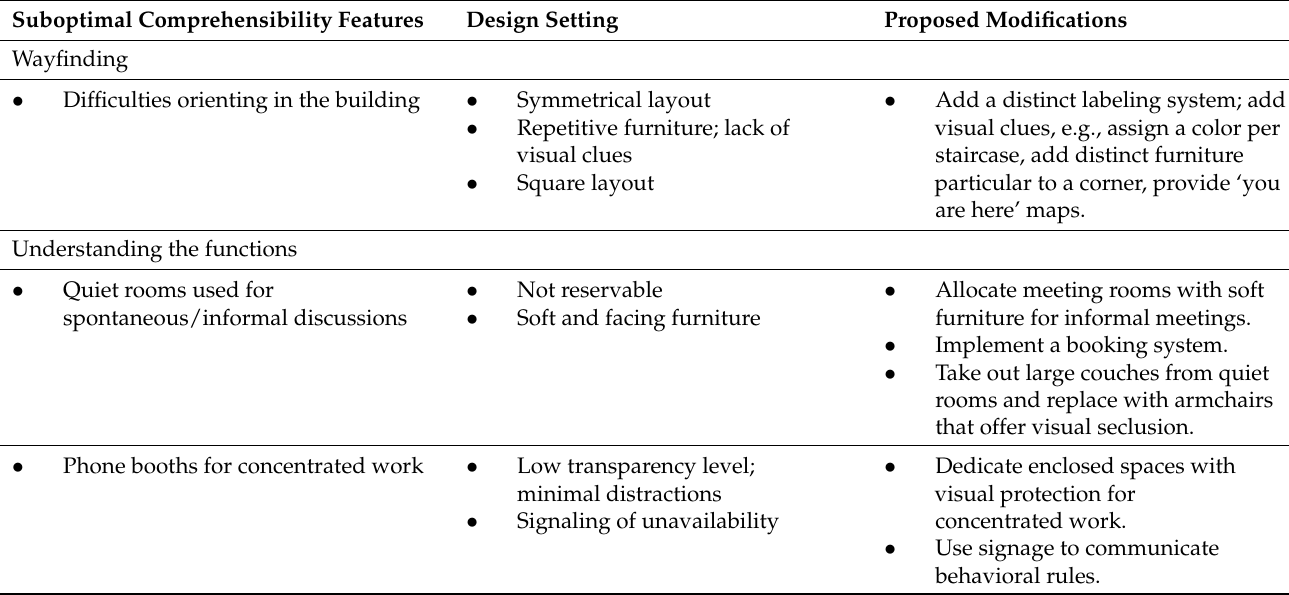
Table 5. Proposed